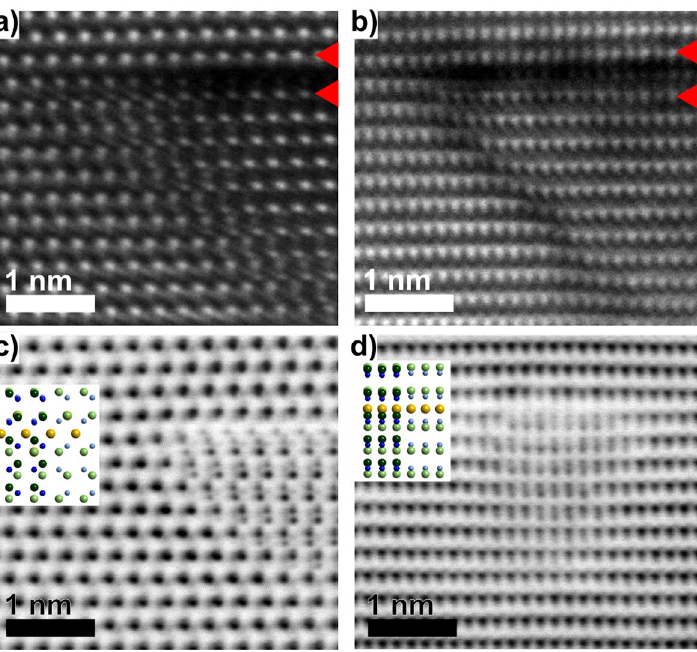
Figure 3. Acquired images of top-left side of the PIDs: by HAADF-STEM ( a – b ) and by ABF-STEM ( c – d ) for < 11 ¯ 20 > a) and ( c ) and < 1 ¯ 100 > ( b ) and ( d ) projections respectively. The right side of insets in ( c ) and ( d ) show the top Mg-layer and the inversion, while the left sides show the same but overlapping with the ambient matrix. For the model structures, Ga is light green, N is light blue, and Mg is yellow. The dark green and blue are the corresponding atoms but for the ambient matrix overlapping the structure.